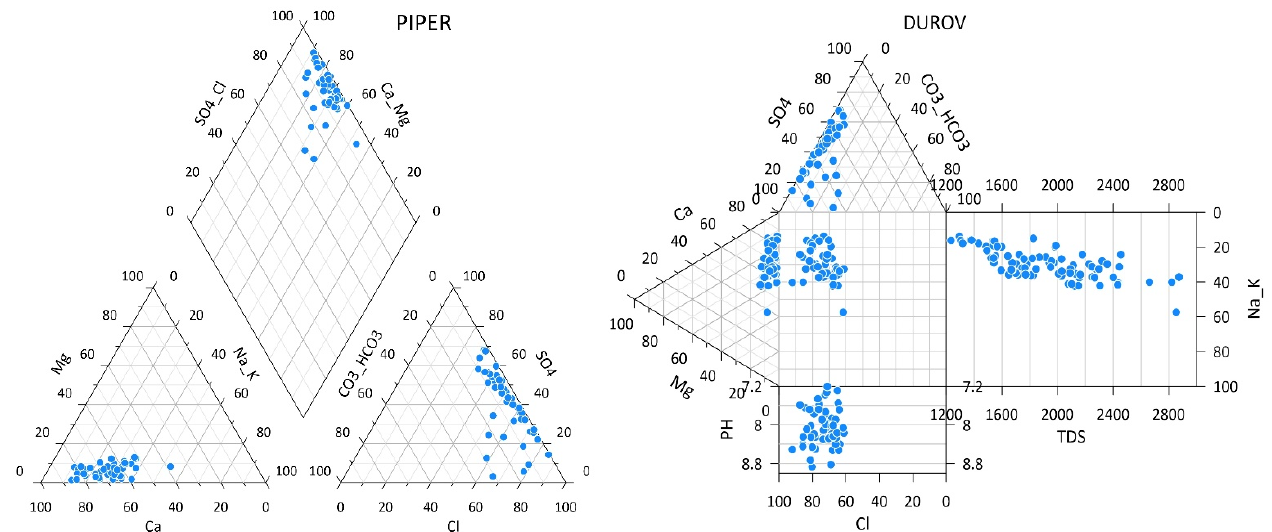
Figure 10. Piper and Durov diagrams for groundwater samples of the study area after sewerage.